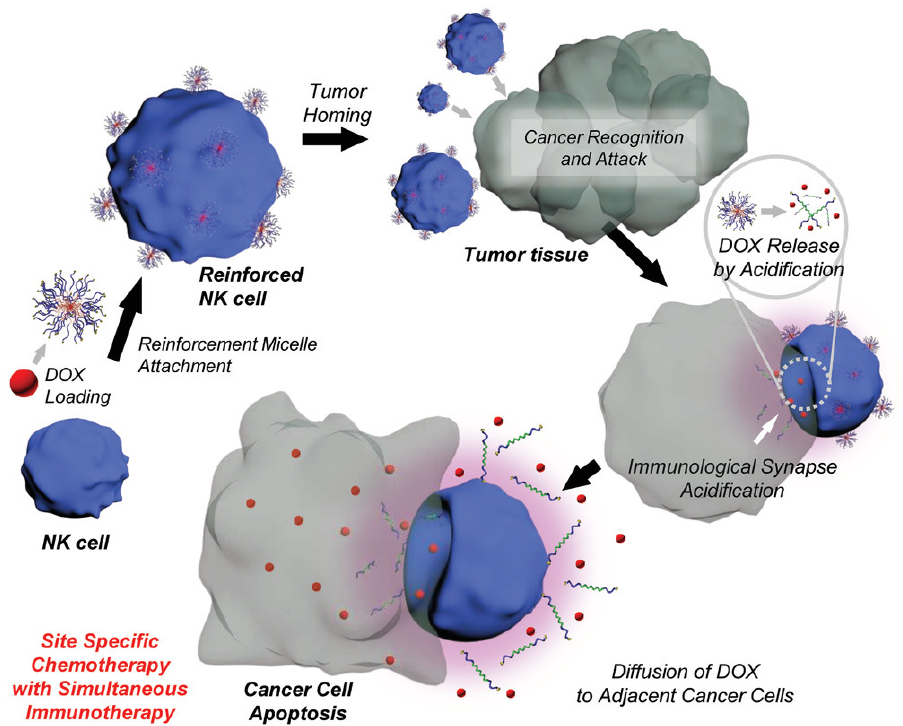
Figure 5. Schematic illustration of the reinforced natural killer cell (ReNK) system and its anti-cancer effect upon encountering cancer cells. Reprinted with permission from Ref. [37]. Copyright 2020 John Willey and Sons.